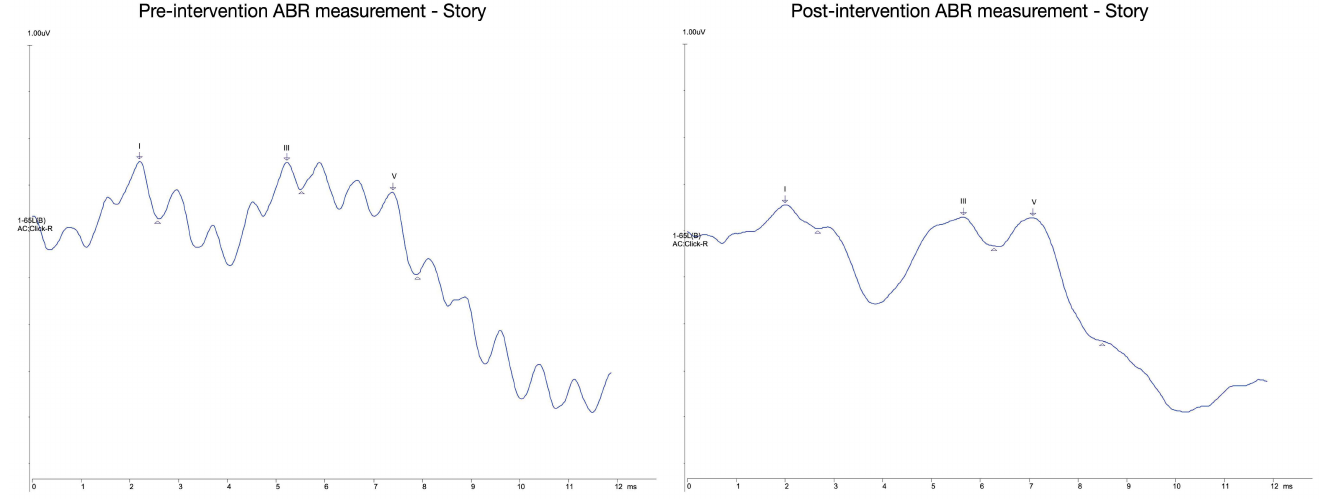
Figure 1. Averaged waveforms for the SEG (pre-post intervention).